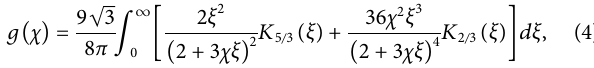
e in the z direction(blue dots) feltby themacroelectronwith the maximum χ 0 /